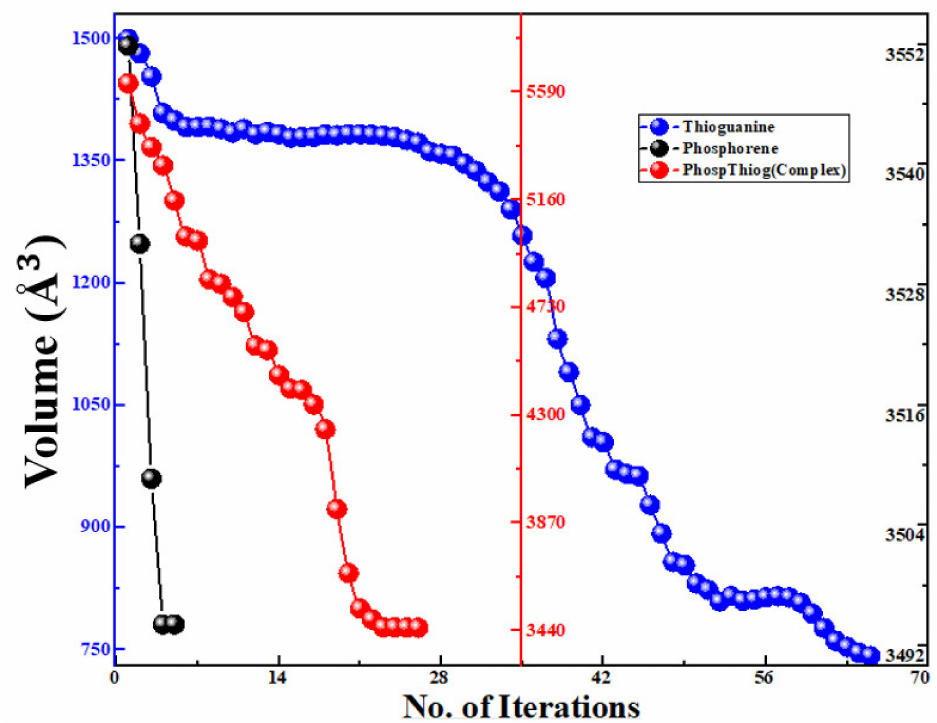
Figure 3. Volume versus the number of iterations of phosphorene, thioguanine, and phosphorene– thioguanine